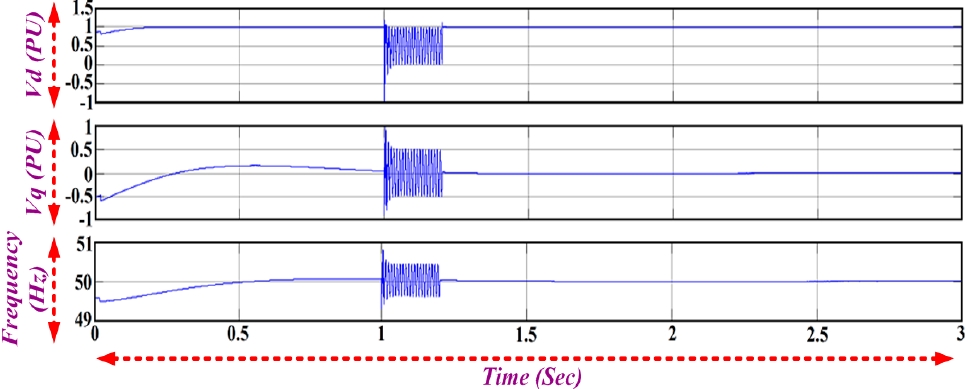
Figure 16. Graph of V d , V q , and Frequency.